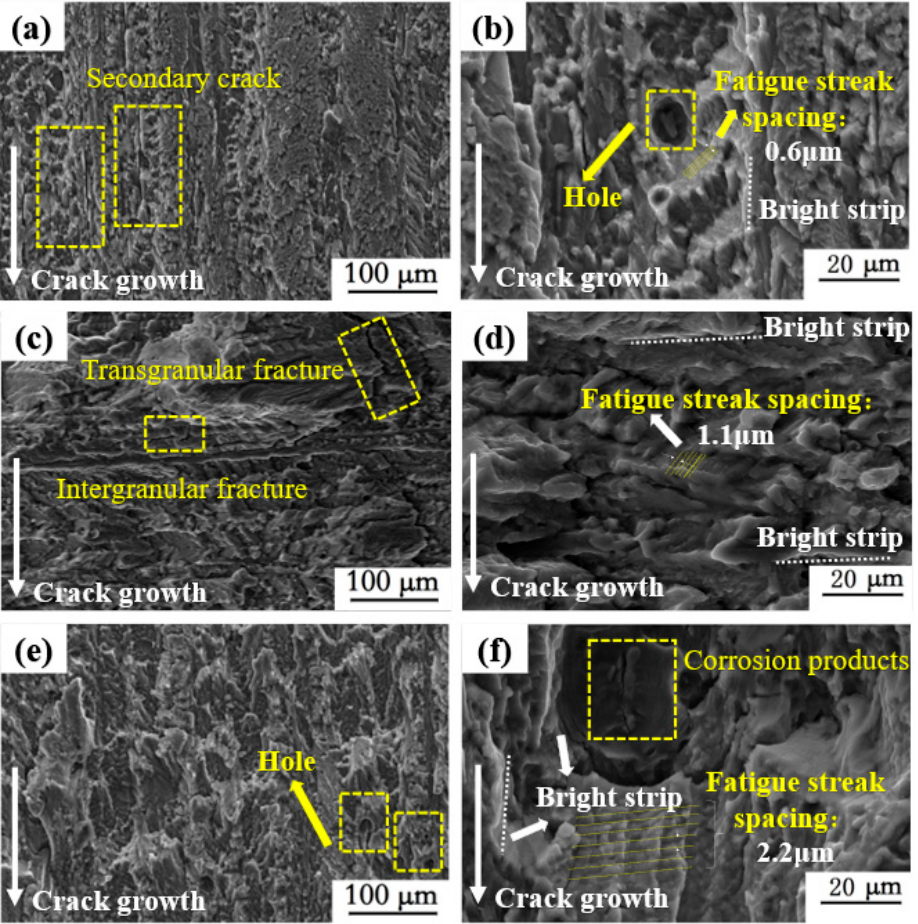
Figure 5. Microstructure of CFCG fracture surface of different fatigue − damaged samples ( a , b ) P 0 , ( c , d ) P 1 , ( e , f ) P 2